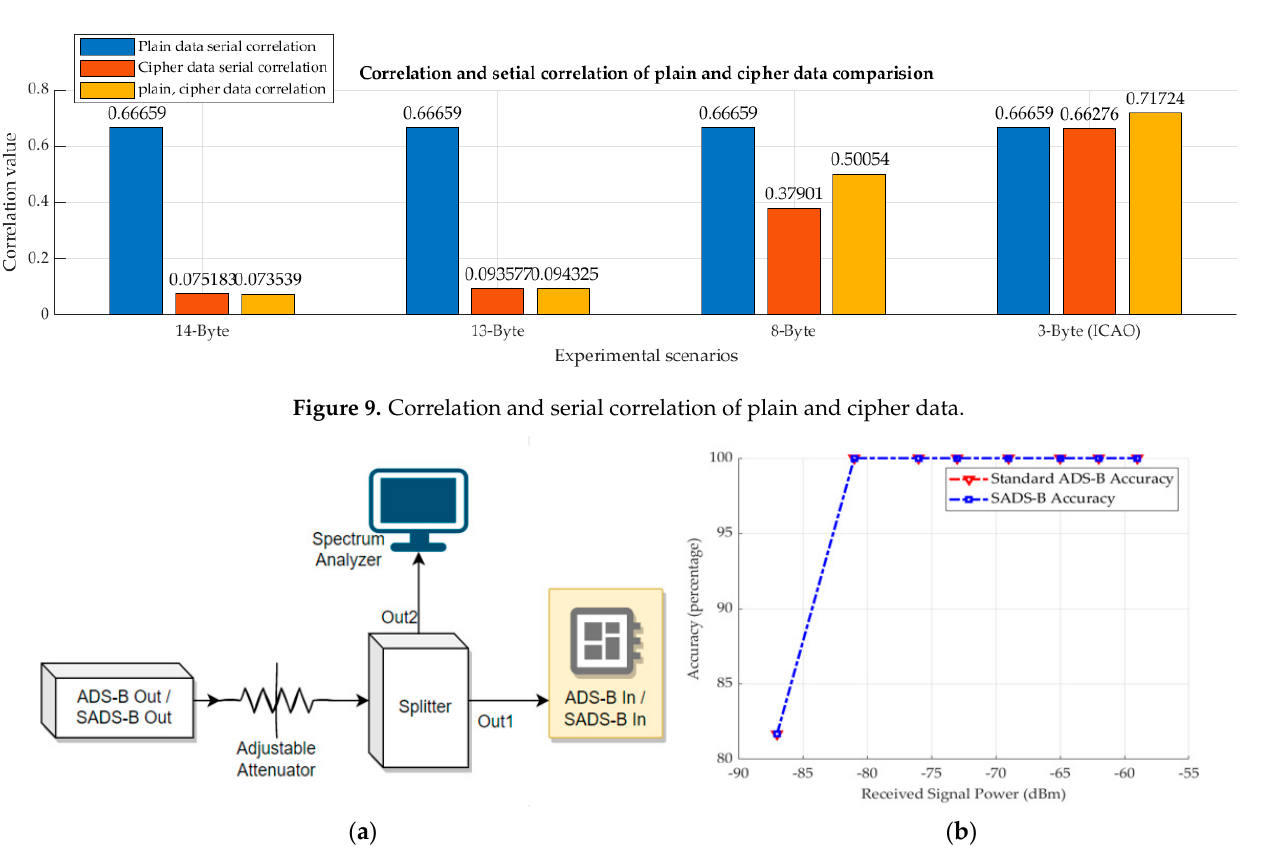
Figure 10. ( a ) Sensitivity test bench block diagram, ( b ) Measured accuracy of standard ADS-B and SADS-B signals.